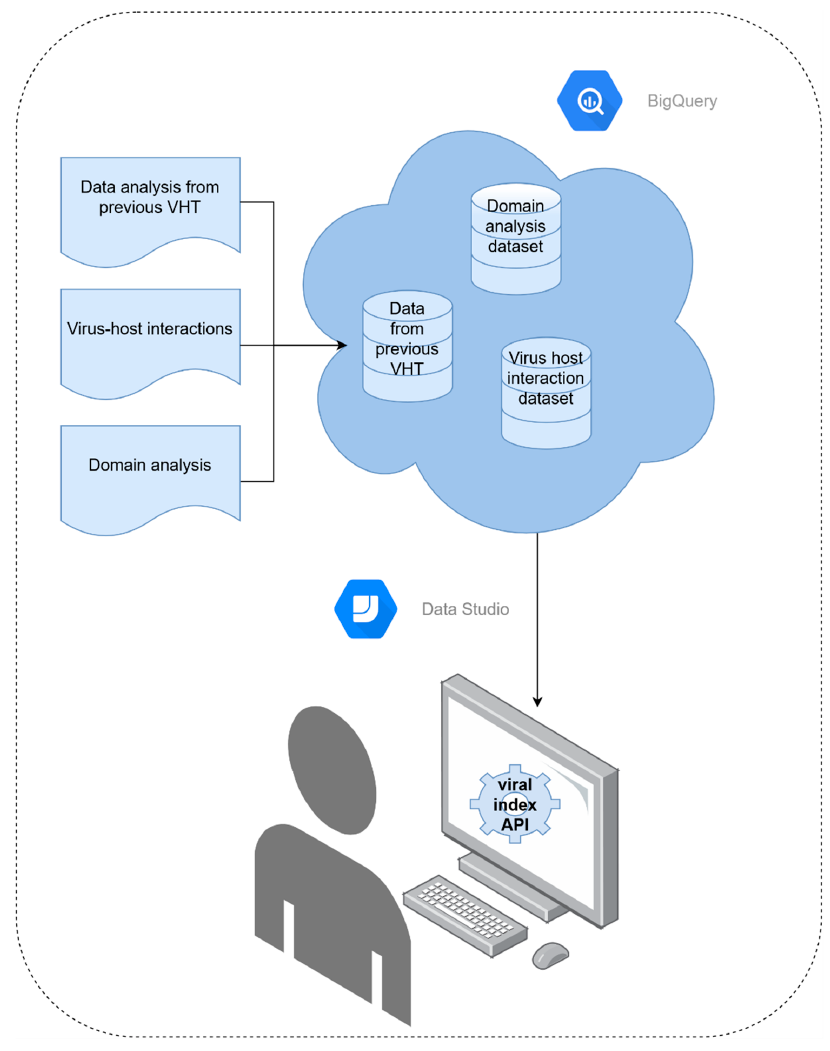
Figure 2. A schematic representation of Federated Index of Viral Experiments (FIVE) implementation, and interactions with users, enabled through the viral-index Application Programming Interface